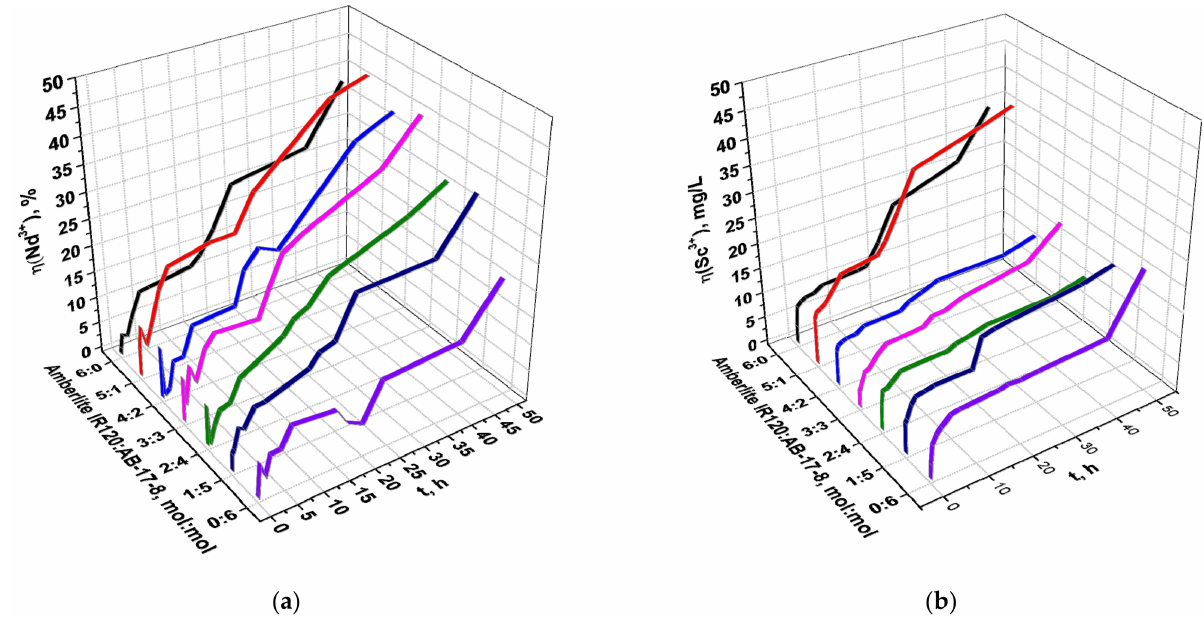
Figure 5. The extraction degree of Nd 3+ ( a ) and Sc 3+ ( b ) of interpolymer system, Amberlite IR120-AB-17-8. Polymer chain binding degree (relatively to Nd 3+ (a) and Sc 3+ (b)) of the interpolymer system Amberlite IR120-AB-17-8 is presented in Figure 6 is dependent on the ion-exchange resins’ molar ratios of and interaction time. Significant increase of binding degree (in relation to neodymium ions) in the interpolymer system is observed from the moment of sorption beginning (0.1 h), binding degree at ratio Amberlite IR120:AB-17-8 = 5:1 is 0.39%, while it is 0.08% for Amberlite IR120 and 0.07% for AB-17-8. Subsequent strong increase comparatively with individual ion-exchangers is observed at this ratio at 0.5 h of interaction, the parameter is 0.72% for Amberlite IR120:AB-17-8 = 5:1, 0.27% for Amberlite IR120 and 0.52% for AB-17-8. The emote interaction in this interpolymer pair leads to areas of high binding of neodymium ions at 15. The binding degree at 15 h is 1.58%, while it is 0.92% for Amberlite IR120 and 0.82% for AB-17-8. The end of sorption (40 h) is accompanied with area of strong difference in values of polymer chain binding degree, for Amberlite IR120:AB-17-8 = 5:1 binding degree is 3.06%, while it is 2.10% for Amberlite IR120 and 1.06% for